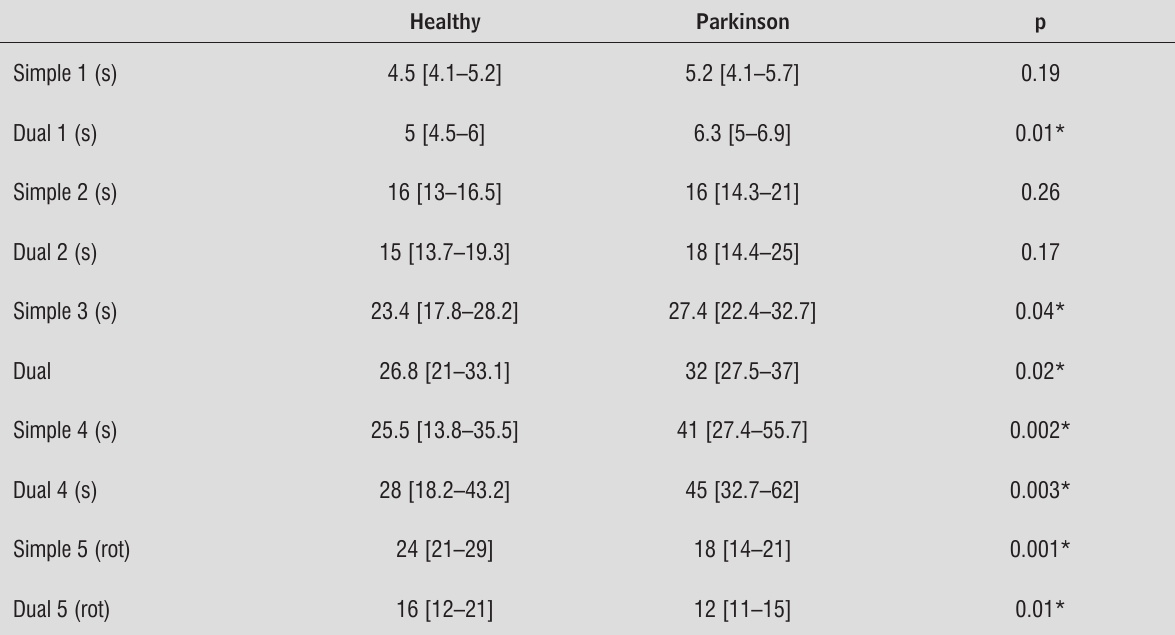
Table 3 - Dual-task performance of healthy individuals and individuals with Parkinson’s disease: median and interquartile